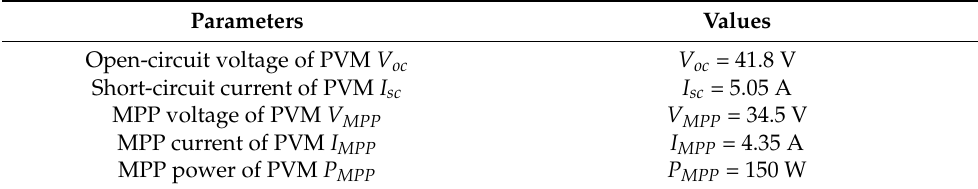
Table 1. Single PVM parameters of this